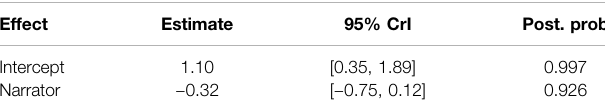
TABLE 1 | Results from statistical analysis — estimates of the model, corresponding95%credible intervals(95% CrI) and theposteriorprobabilities (Post. Prob.). Effects forwhichthe CrI excludeszero are shown in bold. ‘ Intercept ’ denotes theeffectofselecting CVG more often than OVG in theCPcondition, and Narrator denotes the effect of selecting CVG in the Narrator condition compared to the CP.